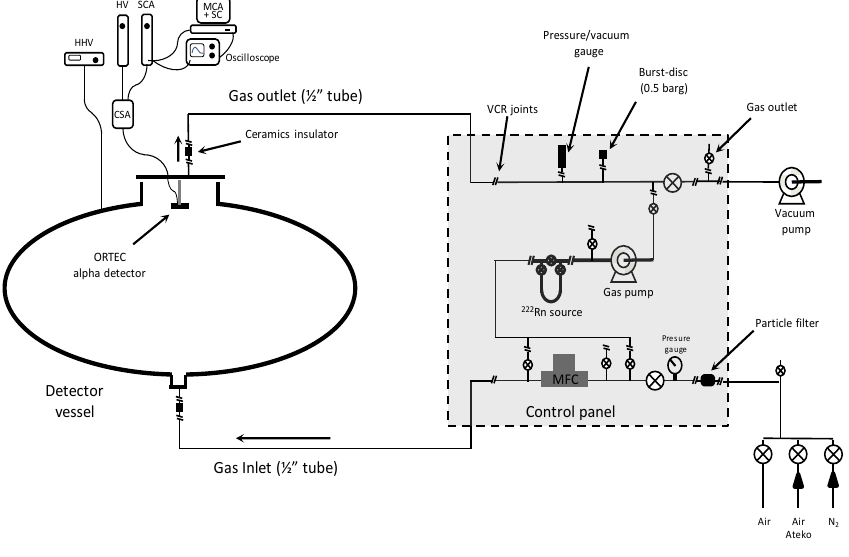
Figure 7. Schematic of the ERM detector and gas